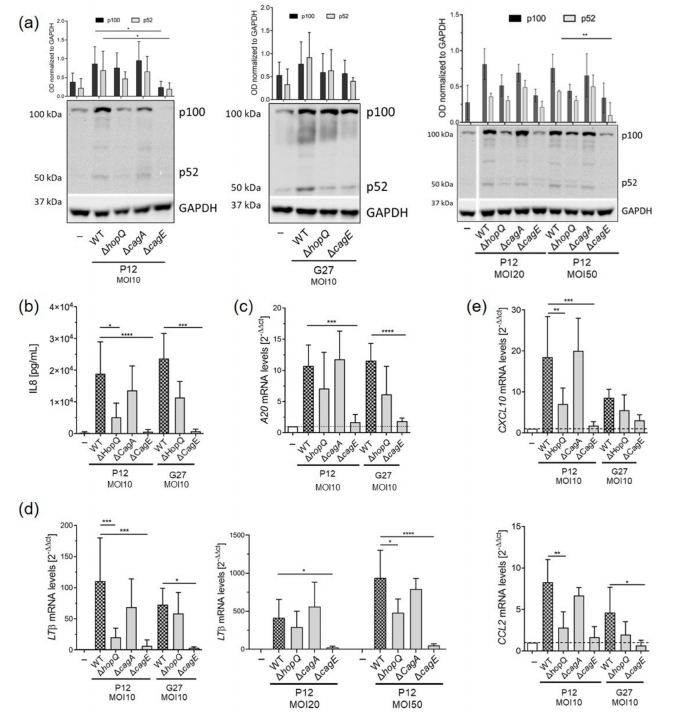
Figure 1. Activation of the non-canonical NF- κ B pathway upon H. pylori infection in MKN45 gastric cells. MKN45 cells were infected with P12 or G27 wild type H. pylori strains or isogenic mutant strains at an MOI of 10, 20 or 50 for 8 h. ( a ) p100 to p52 processing detected by Western blot. GAPDH was used as loading control. ( b ) IL8 secretion was measured by ELISA. ( c ) A20 , ( d ) LT β and ( e ) CXCL10 and CCL2 mRNA levels were analyzed by qPCR. GAPDH was used as a housekeeping gene. All qPCR values were normalized to uninfected controls and calculated using the 2 - ∆∆ ct equation. Graphs show mean ± SD of at least three independent experiments. One-way ANOVA with Bonferroni correction ( a , c – e ) or Kruskal–Wallis with Dunn’s correction ( b ). * p ≤ 0.05; ** p ≤ 0.01; *** p ≤ 0.001; **** p ≤